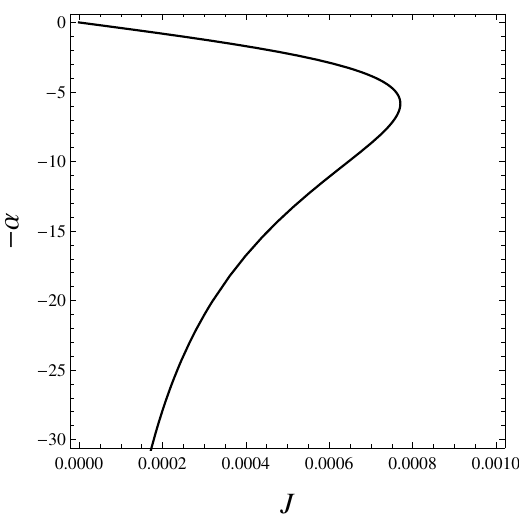
Figure 6. Stability curve − α ( J ) at fixed β of the standard case in the canonical treatment. There is a vertical tangent. The more stable positive slope branch corresponds to fast rotation ( h > h c ). The less stable negative slope branch corresponds to slow rotation ( h < h c